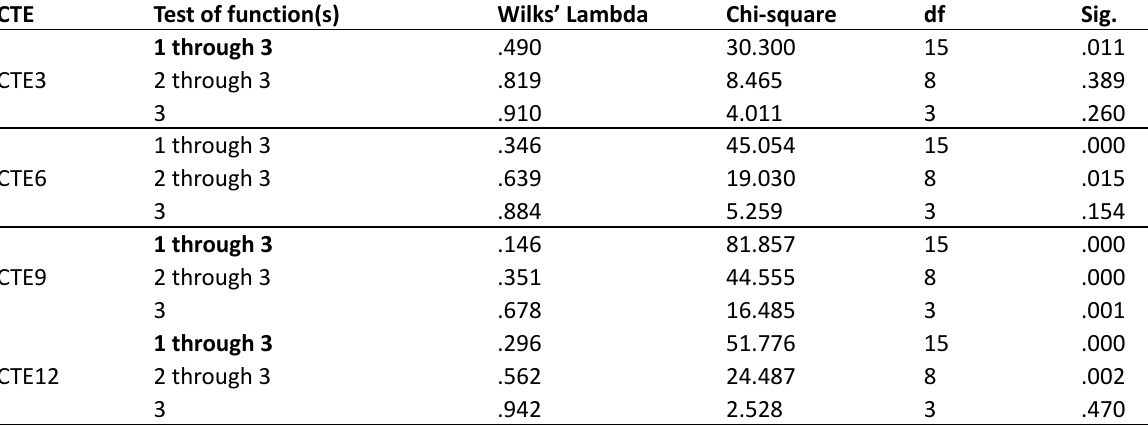
Table 4. Test of function(s). Boys aged 8 CTE